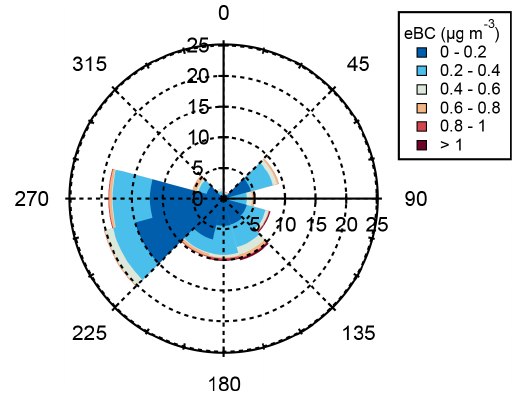
Figure 4. Box plot showing the daily pattern of rBC GMD (2h av- erages) as measured by the SP2, at the urban and rural sites. Boxes show the median and the 25th and 75th percentiles, with values more than 1.5 below or above those considered outliers ( + ).